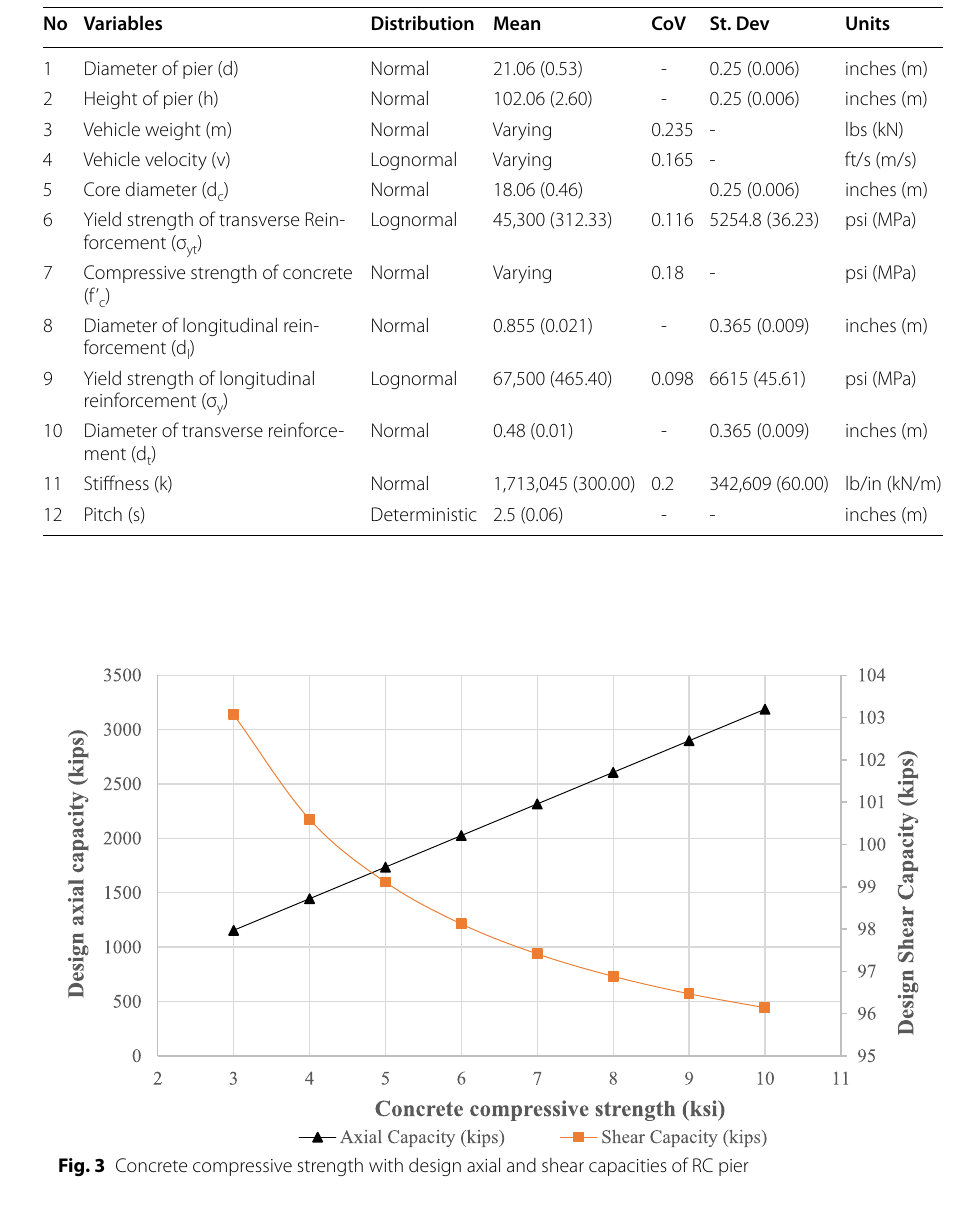
Table 2 Design variables and their uncertainty parameters